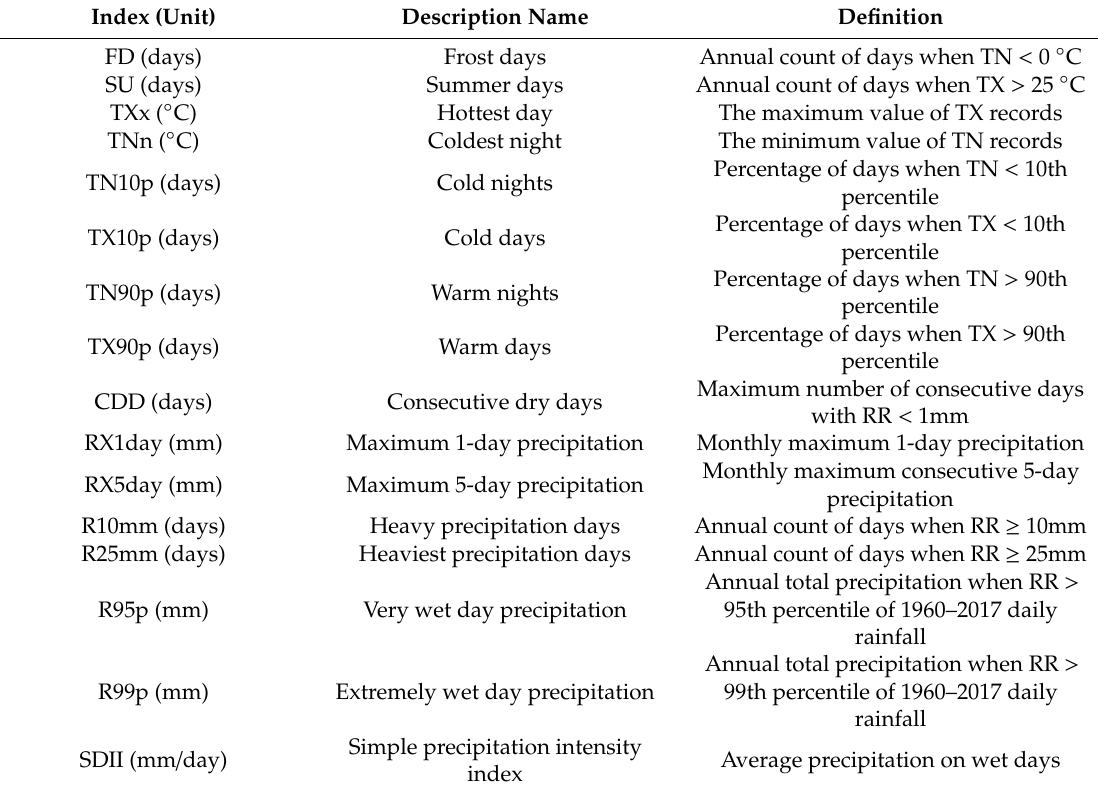
Figure 1. The Digital Elevation Model (DEM) and location of the meteorological stations in this study. The two straight lines dividing the basin into three regions are from the following points: A (34 ◦ 15 (cid:48) N, 104 ◦ 45 (cid:48) E); B (37 ◦ 10 (cid:48) N, 103 ◦ 00 (cid:48) E); C (34 ◦ 15 (cid:48) N, 107 ◦ 15 (cid:48) E); and D (36 ◦ 45 (cid:48) N, 112 ◦ 30 (cid:48) E). Table 1. Definitions of the temperature and precipitation indices used in this study.